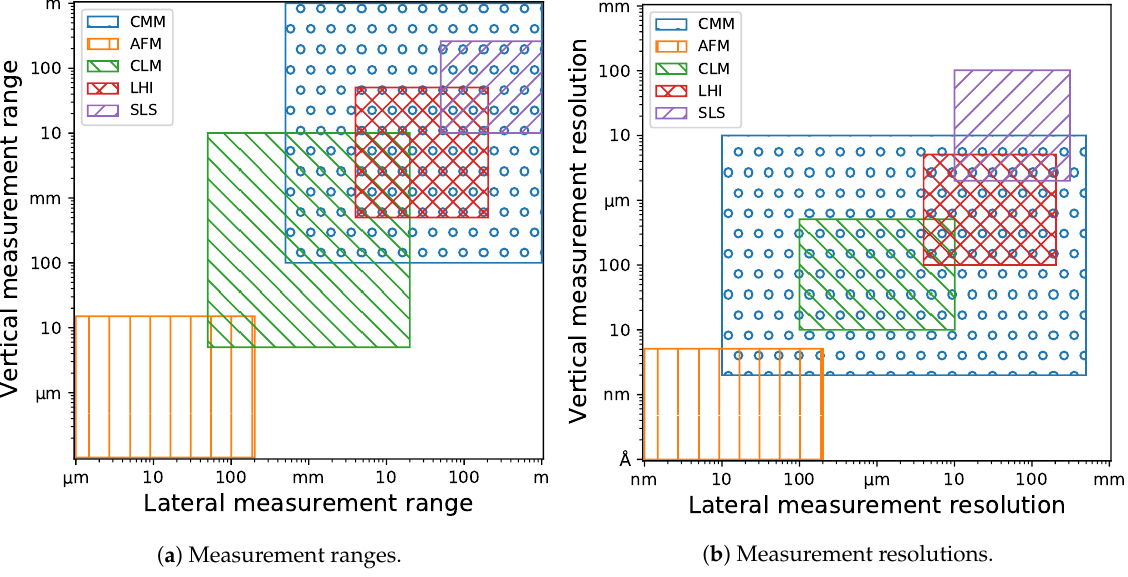
( a ) Measurement ranges. ( b ) Measurement resolutions. Figure 2. Typical measurement ranges and resolutions for the representative